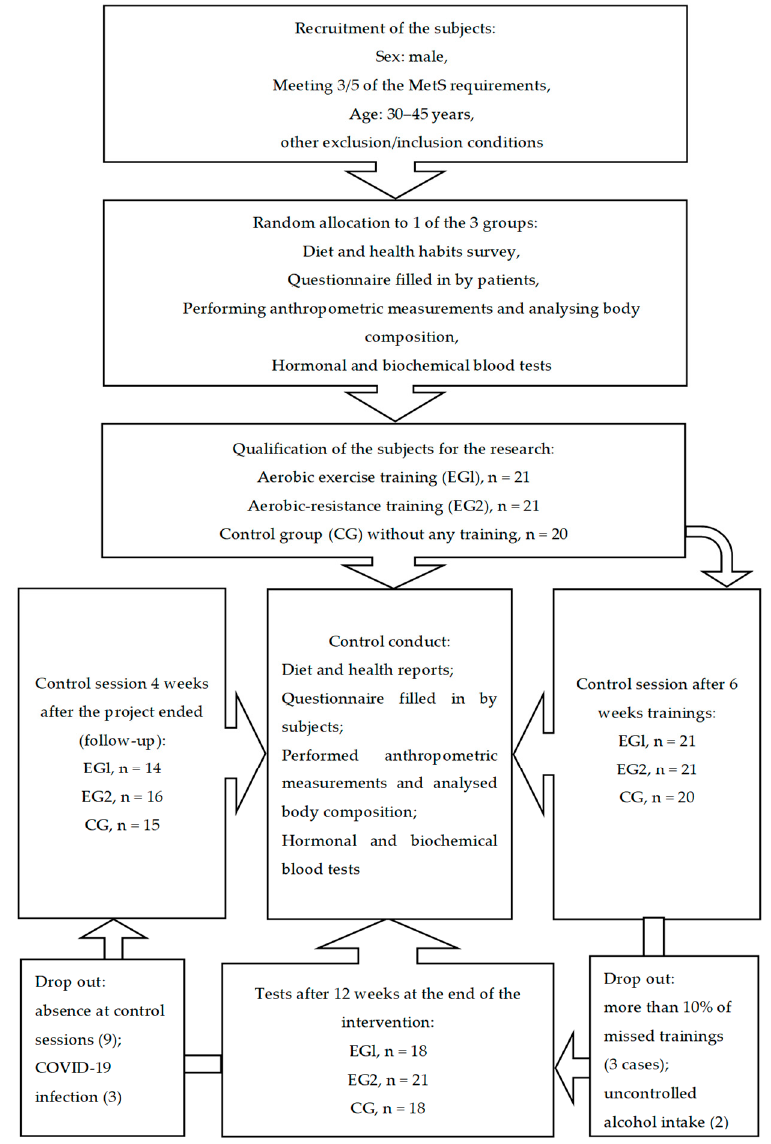
Figure 1. The course of the study.